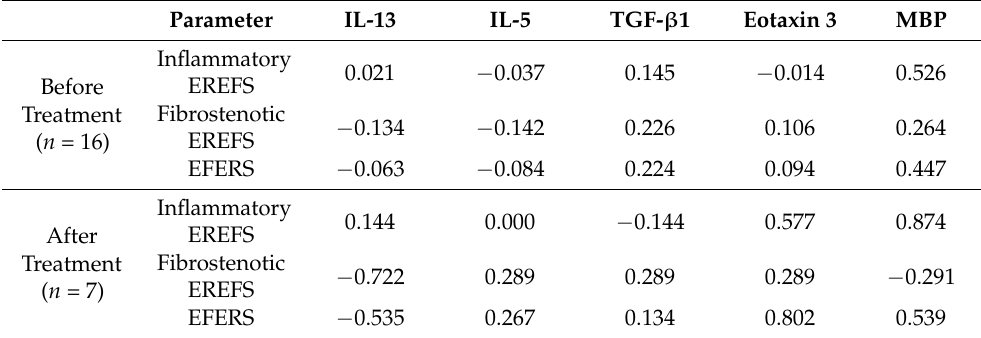
Table 3. Spearman’s rank correlation coefficients between biomarkers and EREFS subscores, before and after treatment. IL-13 IL-5 TGF- β 1 Eotaxin 3